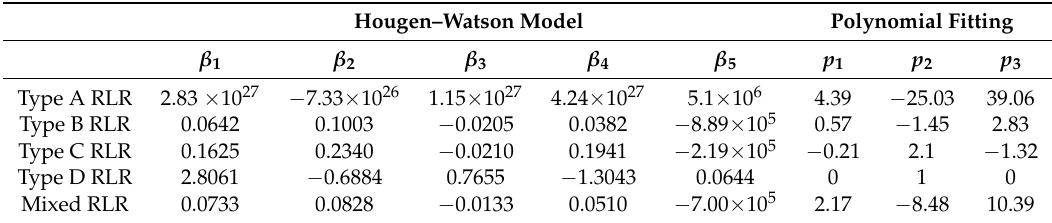
Figure 9. Prediction models of all red-light extension time for each RLR class type. Table 4. Coefficients of prediction models for all-red signal extension time. (Mixed RLR represents the prediction model shown in Figure 8 and others are corresponding to models shown in Figure